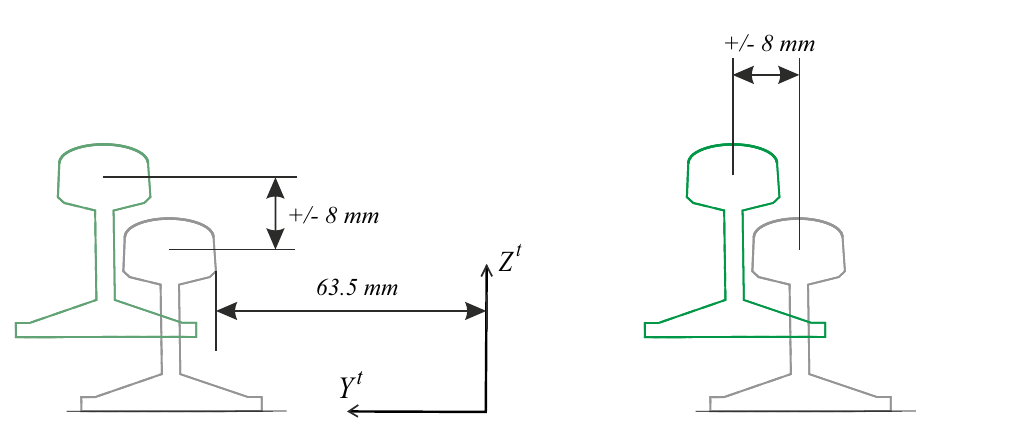
Figure 2. Support mechanisms design.